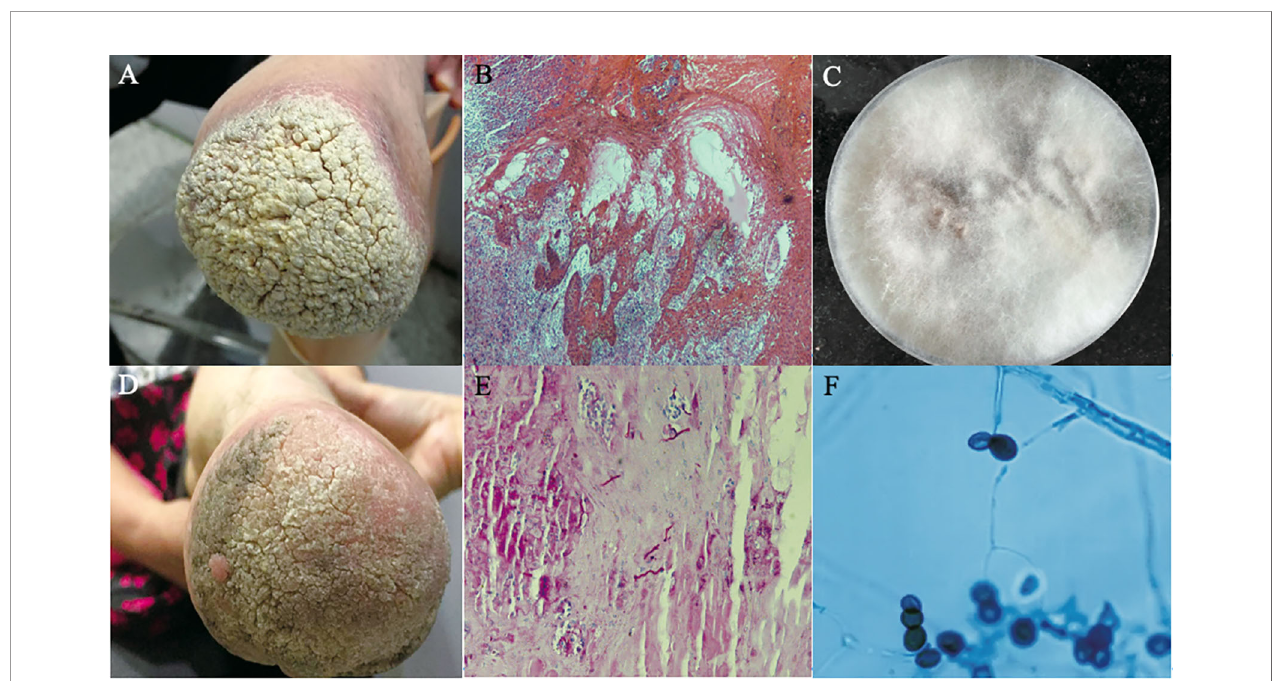
FIGURE 5 | Diagnosis of a case of PHM caused by Arthrinium phaeospermum . (A) Hypertrophic verrucous plaques with basal in fi ltrating erythema at the distal left lower extremity in a 59-year-old female with a history of double limb amputations for 20 years; (B) Resolved lesions upon follow up after one month; (C) Hematoxylin-eosin (HE) stained tissue sections showed papillomatous hyperplasia of the spinous layer, mild interspinous cell edema, vascular hyperplasia of the dermal papillary layer, scattered dotted cell in fi ltration and collagen fi ber hyperplasia (HE × 40); (D) Periodic acid-Schiff (PAS) stained tissue sections showed scattered hyphae on the epidermis (PAS × 100); (E) Colonies on sabouraud dextrose agar (SDA) at 26°C for 2 weeks were hairy, velvety and greyish-white on the front and orange on the back; (F) Structures under microculture on potato dextrose agar (PDA) showed that transparent conidia grew from calabash type mother cells and produced lateral conidia. The lens of the conidia eye was black and brown, with a linear bud splitting in middle latitude (lactophenol-cotton blue stain × 400); (Reproduced from reference Zhou et al. (2016) [original Figure 1 –